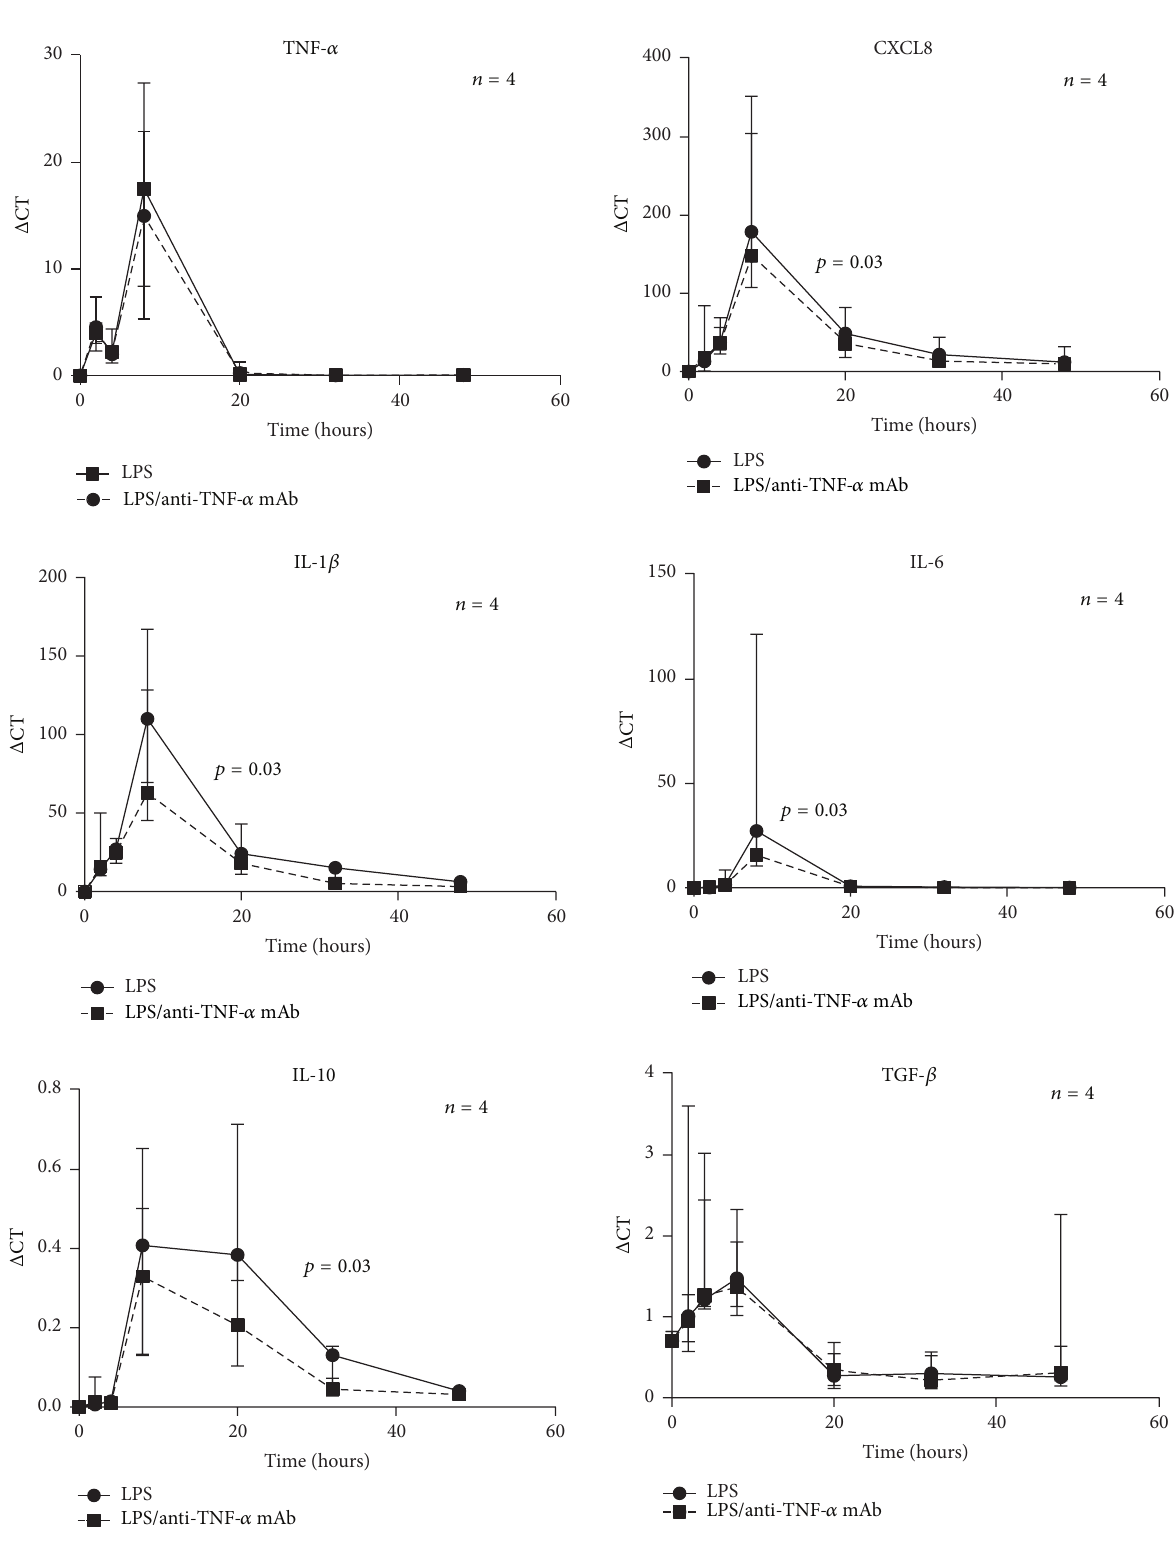
Figure 1: Effect of TNF- 𝛼 mAb on pro- and anti-inflammatory cytokine mRNA expression in LPS-stimulated monocytes. Each figure illustrates a time course experiment showing cytokine mRNA expression by monocytes stimulated with LPS (100ng/mL) ± TNF- 𝛼 mAb (10 𝜇 g/mL). Data points are expressed as median (range). AUC values were compared using the Wilcoxon Signed-Rank Test. 𝑝 values are one-tailed and are shown if significant. A significant reduction in AUC in the presence of TNF- 𝛼 mAb was observed for CXCL8, IL-1 𝛽 , IL-6, and IL-10 ( 𝑝 = 0.03 ). The experiments represent data from 4 subjects. Time points were conducted singly in culture wells and the resultant cellular material in duplicate for subsequent real-time